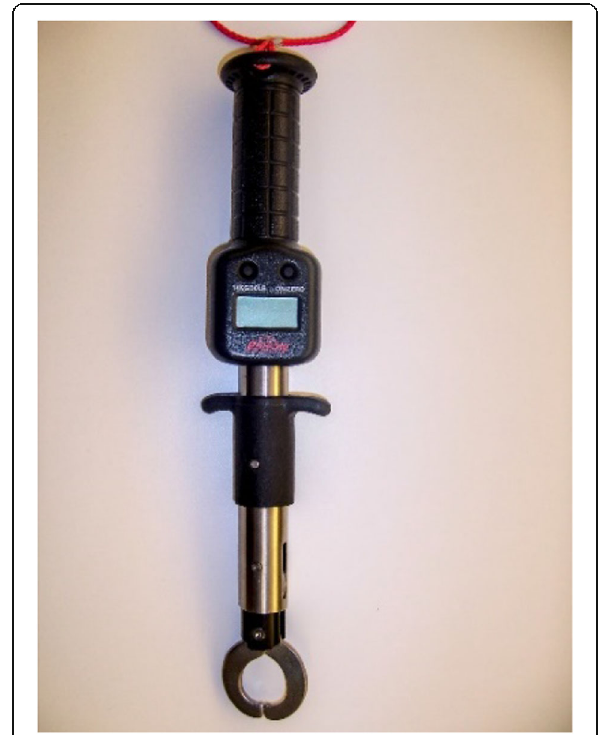
Fig. 2 Digital force measurement device